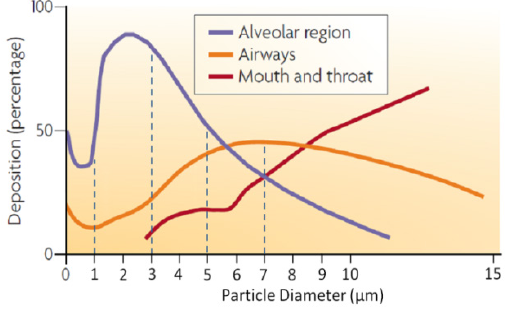
Figure 11. Particle deposition efficiency in human airways and lungs [25]. Table 1. Summary of drugs nebulized using 2 MHz multiple Fourier horn ultrasonic nozzles except